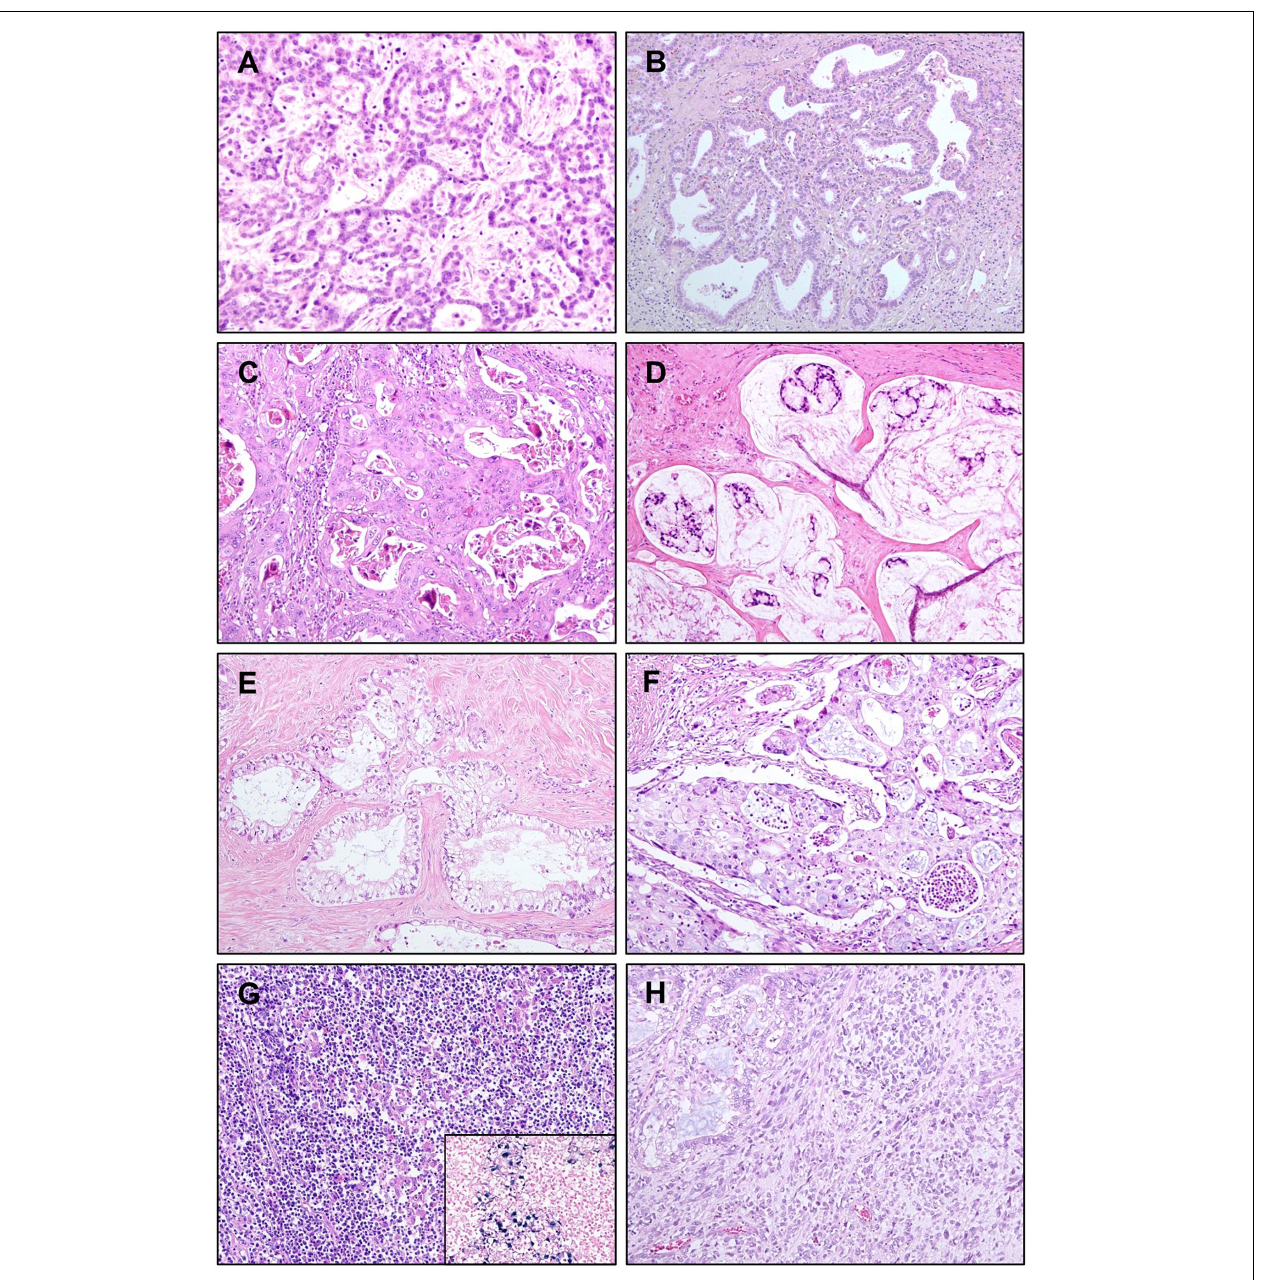
FIGURE 3 | Variants of intrahepatic cholangiocarcinoma (iCCA). (A) Cholangiolocarcinoma. Bland-looking small cuboidal tumor epithelial cells are forming cords or ductules, with antler-like branching pattern. (B) iCCA with ductal plate malformation pattern. Cuboidal tumor cells are forming irregularly dilated and coalesced spaces, resembling developmental anomaly of ductal plate. (C) Adenosquamous carcinoma showing both of gland-forming portion and portions with squamous differentiation. (D) Mucinous carcinoma. Mucin-producing tumor cell clusters are floating in mucin pools. (E) Clear cell carcinoma. Tumor cells have large clear cytoplasm with eccentric nuclei. (F) Mucoepidermoid carcinoma showing squamoid tumor cells intermixed with mucin-producing cells. (G) Lymphoepithelioma-like carcinoma showing marked lymphocytic infiltration into tumor epithelial component. Tumor epithelial cells are positive for Epstein–Barr virus (EBV), detected by in situ hybridization of EBV-encoded small RNA (inset). (H) Sarcomatous iCCA showing mainly pleomorphic spindle cells, with adenocarcinoma components in the upper left corner. Original magnification: 100 ×